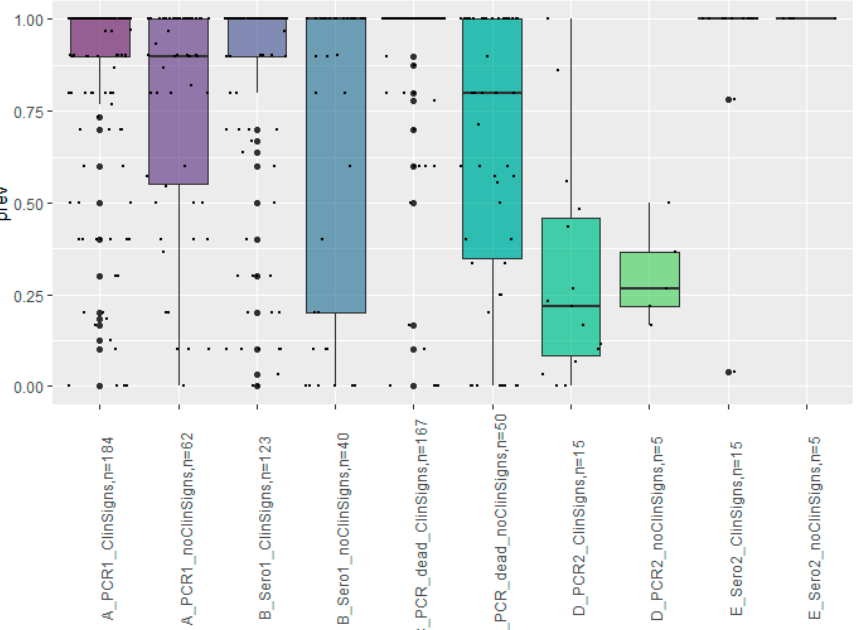
Figure 3. Anti-SARS-CoV-2 seroprevalence (B,E) and virus prevalence (PCR, A, C, D) in Danish mink farms in the period from 15 June to 12 November 2020, at first and second sampling dates (A, B, D, E) and virus prevalence in dead mink (C). All dead mink were from the first sampling date. Farms are divided in farms where clinical signs were observed (ClinSigns), and farms without observations of clinical signs (noClinSigns). The number of farms included in each type of sampling is indicated as n. Most often, samples from 10 live mink were taken from each farm, but with some variation (1–30 samples), as well as samples from 5 to 10 dead mink. The thick line illustrates the median, 50% of the observations are within the box, whiskers show the largest values no further than 1.5 inter-quartile range from the box, and dots beyond the whiskers indicate outliers. The small dots (jitters) within the box and whiskers illustrate the observations (one for each farm).